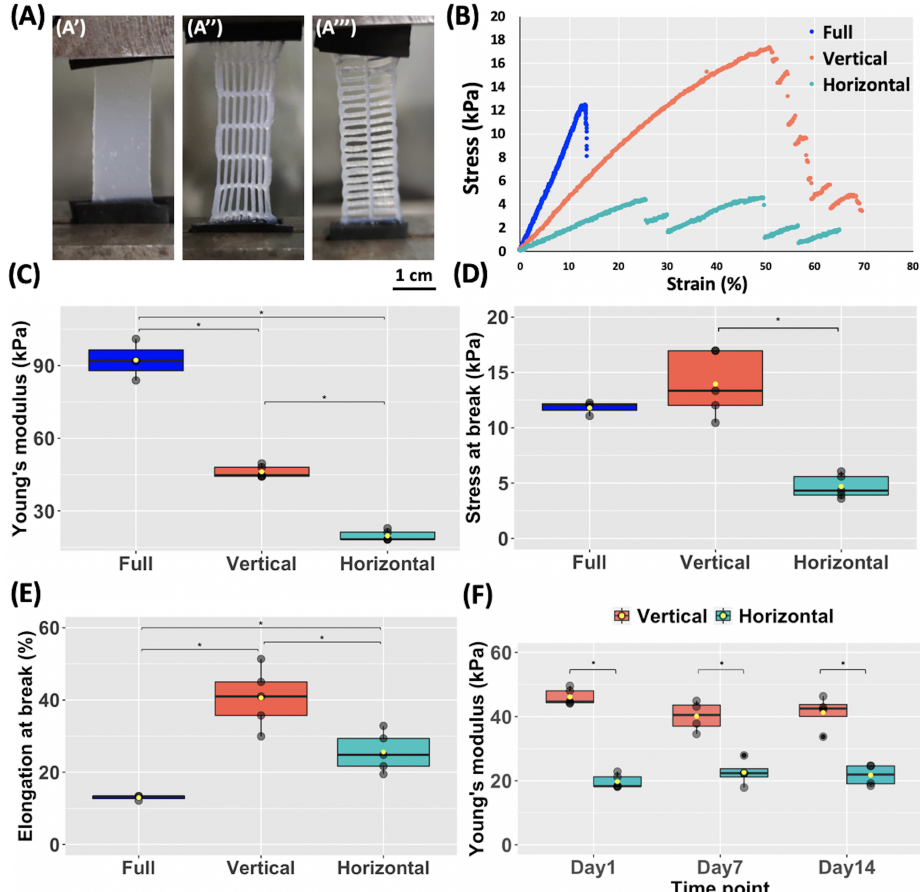
Figure 4. Uniaxial tensile testing of CH–Gel–GG membranes. ( A ) Photographs of ( A’ ) a full mem- brane, ( A” ) a membrane with vertically oriented pores and ( A”’ ) a membrane with horizontally oriented pores during the tensile test. ( B ) Representative uniaxial tensile stress—strain plots for full (blue), vertically (orange), and horizontally (green) pore-oriented membranes. ( C ) Average Young’s modulus calculated from the linear region of the stress–strain curve, average stress at break ( D ), and average elongation at the break ( E ) of membranes (n = 3 for full membranes and n = 5 for each group). ( F ) Average Young’s modulus of the vertically and horizontally pore-oriented membranes on day 1, day 7, and day 14 after printing and incubation in PBS at 37 °C (n = 5 for each condition on day 1, n = 4 for each condition at days 7 and 14). The boxes represent the central 50% of the data, the horizontal lines correspond to the median, and the whiskers represent the top 25% and the bottom 25% of the data. The yellow point represent the mean (* p <